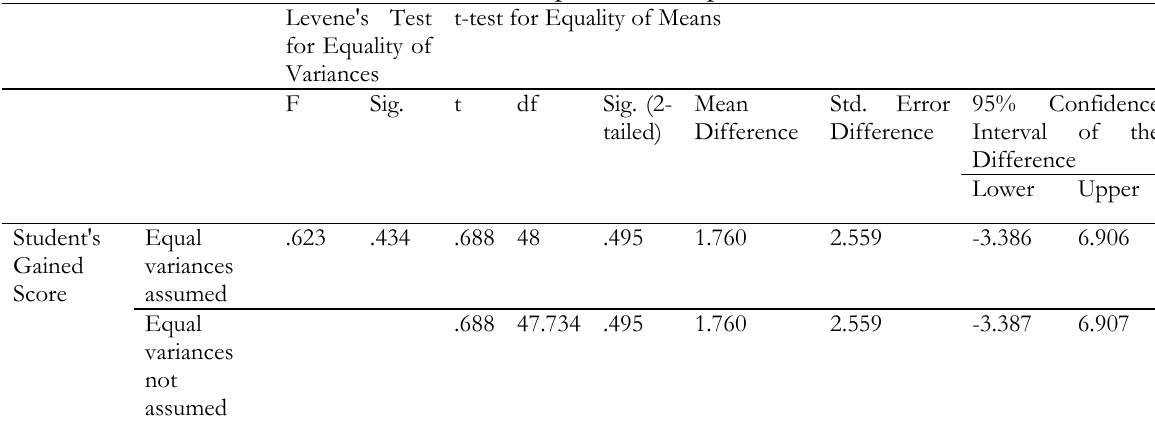
TABLE 6. Independent Samples